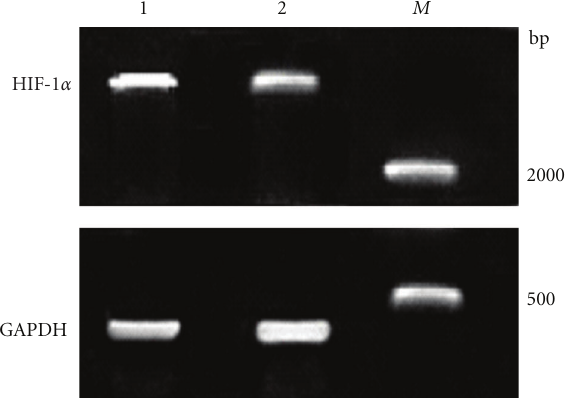
Figure 12: Expression of by RT-PCR. Lane 1 was for HIF-1 α - pcDNA 3 . 1 transfected MSCs and lane 2 for nontransfected, lane M for DL2000 as reference.